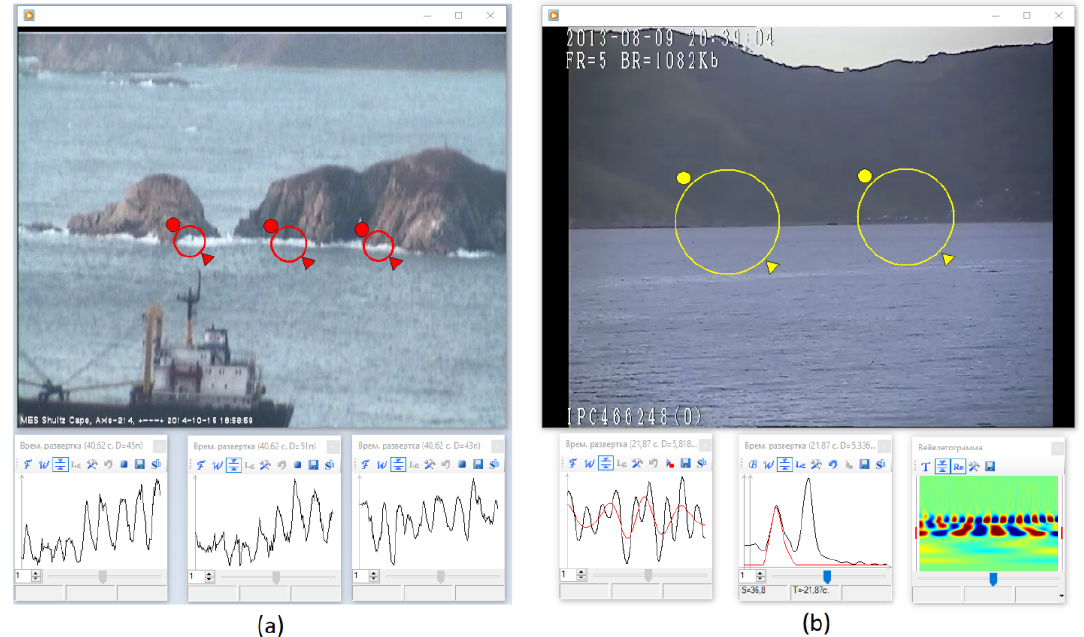
Figure 5. Two methods of detecting a wave signal with Brightness instrument: ( a ) registration of the processes of swell waves breaking when they come ashore; ( b ) registration of apparent movements of the shore during video surveillance from a ship, standing at the pier.